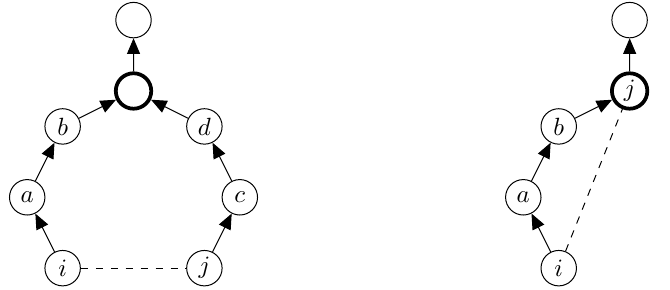
Figure 7 Left: edge [ i, j ] corresponds to two oriented paths, one including a and b , the other including c and d . Right: edge [ i, j ] corresponds to a single path, because one of its endpoints is the apex of C ( i, j ). In both cases, the apex is indicated by a thick line. Oriented arcs indicate predecessors in T ∗